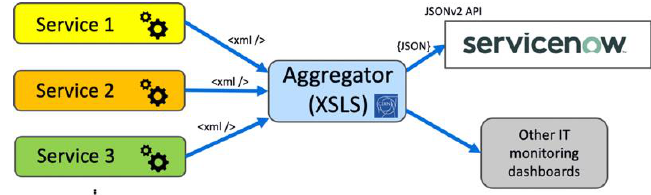
Fig. 4. Flow of information reaching the Service Availability Overview